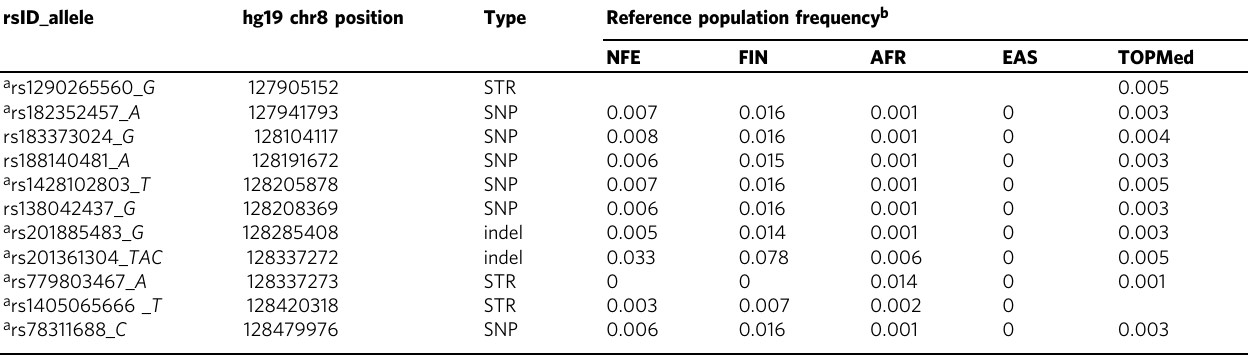
Table 4 Causal mutation candidates of high-risk haplotype